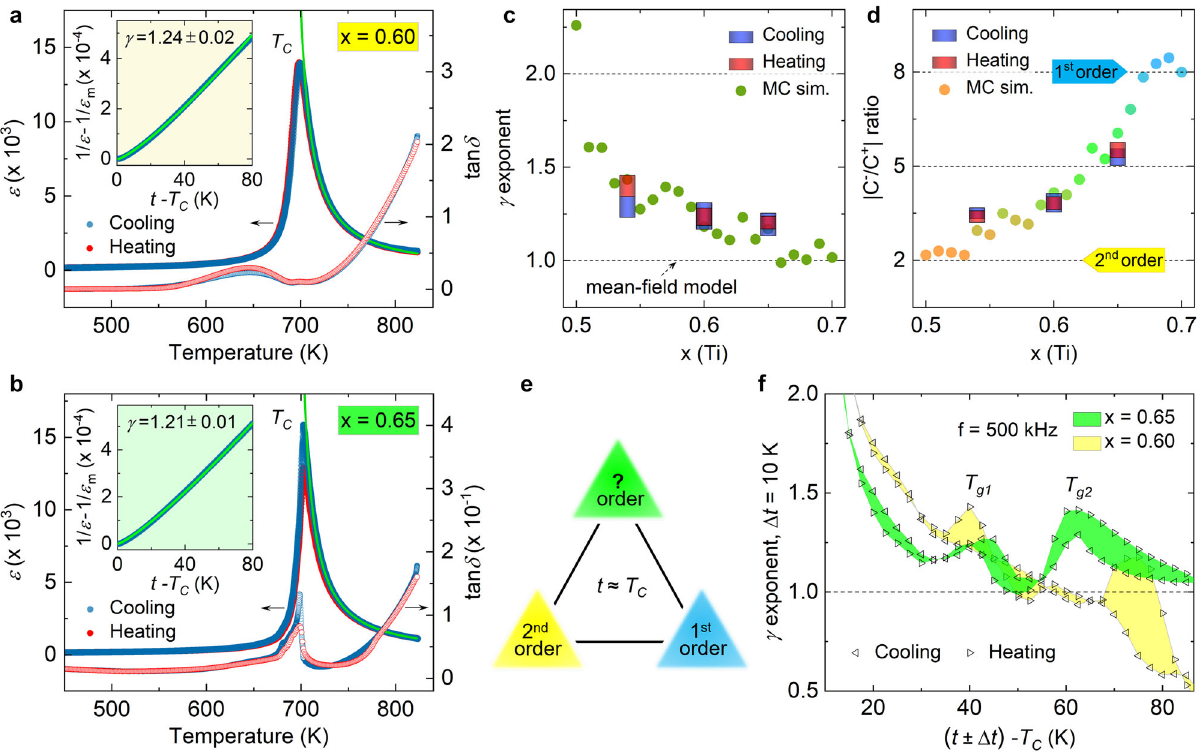
Fig. 3 Dielectric constants and critical exponents. a , b Temperature-dependent ε for x = 0.60 ( T C ≈ 699K) and 0.65 ( T C ≈ 703K) crystal measured at f = 500kHz, respectively. The green solid lines are fi tting to the cooling ε data at t > T γ exponent and Curie-constant ratio | C − / C + | from effective Hamiltonian Monte Carlo simulations and their experimental values measured at f = 500, 333, and 100kHz, respectively. e Illustration of the frustrated PhT order, with | C − / C + | ≈ 5 and γ >1, arising from competing fi rst- and second-order transitions at x T f Temperature-dependent γ exponent measured within a restricted temperature interval ( Δ t = 10K) at t > T C and f = 500 kHz for x = 0.65 and 0.60 crystal (see Supplementary Fig. 11 for x = 0.54